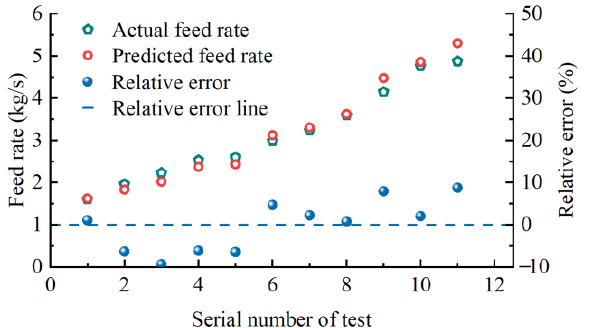
Figure 10. Field experiment.